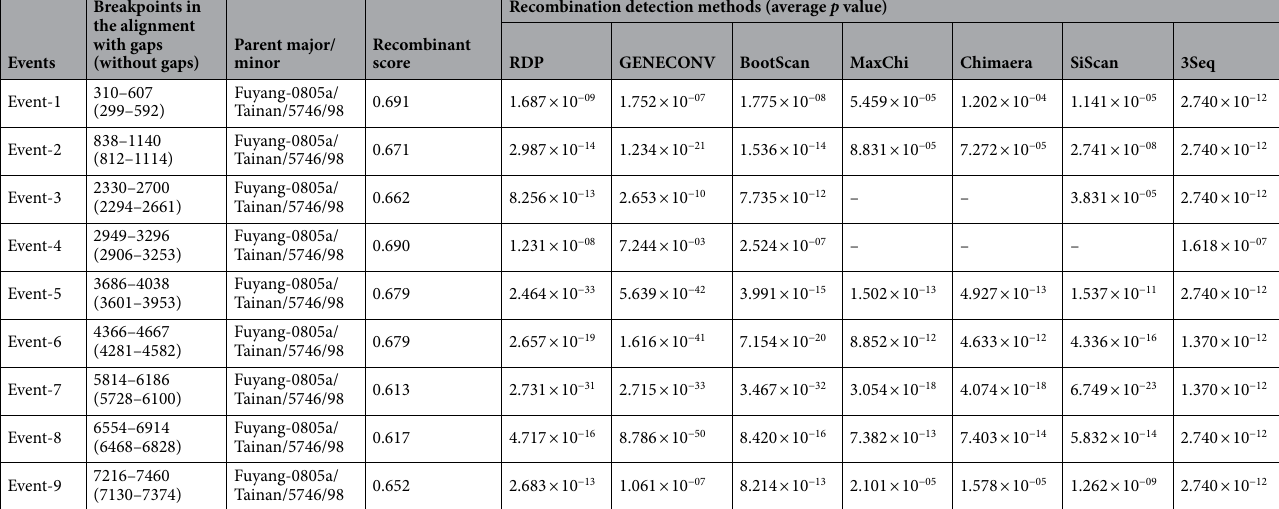
Non-recombination regions in alignment with gaps (nt) Parent major/minor Identity